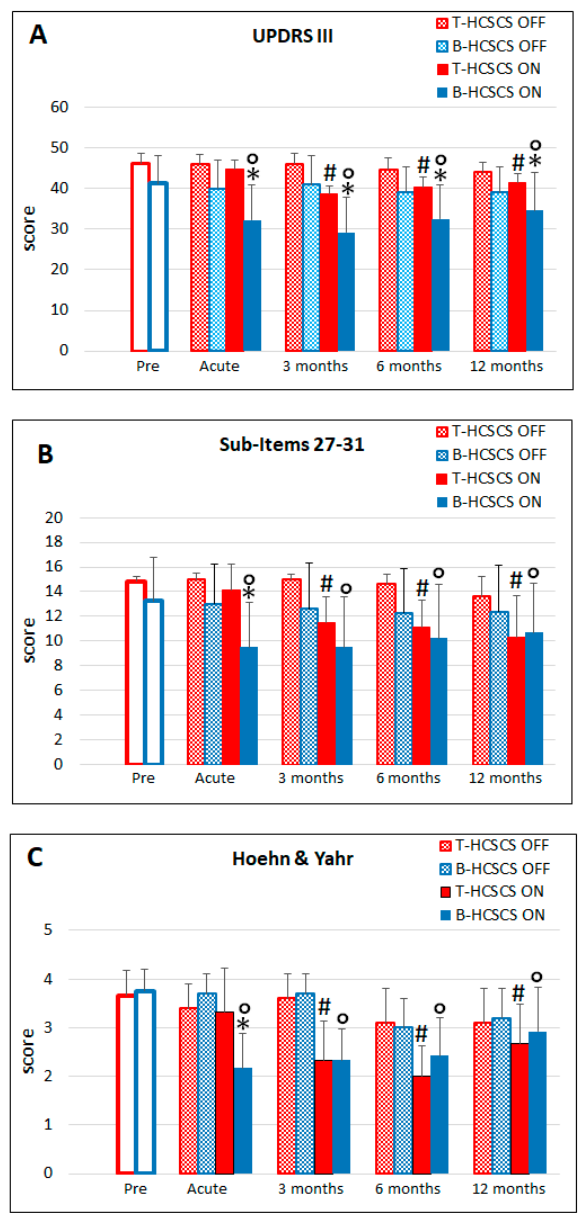
Figure 3. ( A ) Tonic stimulation ( red ) UPDRS scores at 3, 6, and 12 months differed significantly compared to presurgery, stimulation OFF, and acute stimulation values (# p < 0.001). Burst stimulation ( blue ) improved UPDRS scores significantly after acute stimulation as well as at 3, 6, and 12 months ( ◦ p < 0.001) compared to presurgery and stimulation OFF values. Burst stimulation was more effective than tonic stimulation at all the timepoints considered (* p < 0.001). ( B ) 27–31 motor sub-items evaluations at 3, 6, and 12 months differed significantly during tonic stimulation compared to presurgery, stimulation OFF, and acute stimulation values (# p < 0.05). Burst stimulation significantly improved motor sub-items comparing acute, stimulation OFF and 3, 6, and 12 months to presurgery value ( ◦ p < 0.001). Burst stimulation was significantly more effective than tonic stimulation in the acute condition (* p < 0.05). ( C ) Hoehn and Yahr evaluations at 3, 6, and 12 months differed significantly during tonic stimulation compared to presurgery, stimulation OFF, and acute stimulation values (# p < 0.001). Burst stimulation significantly improved Hoehn and Yahr score comparing acute, 3, 6, and 12 months to presurgery and stimulation OFF values ( ◦ p < 0.001). Burst stimulation was significantly more effective than tonic stimulation in the acute condition (* p < 0.05). Statistics were assessed by Friedman